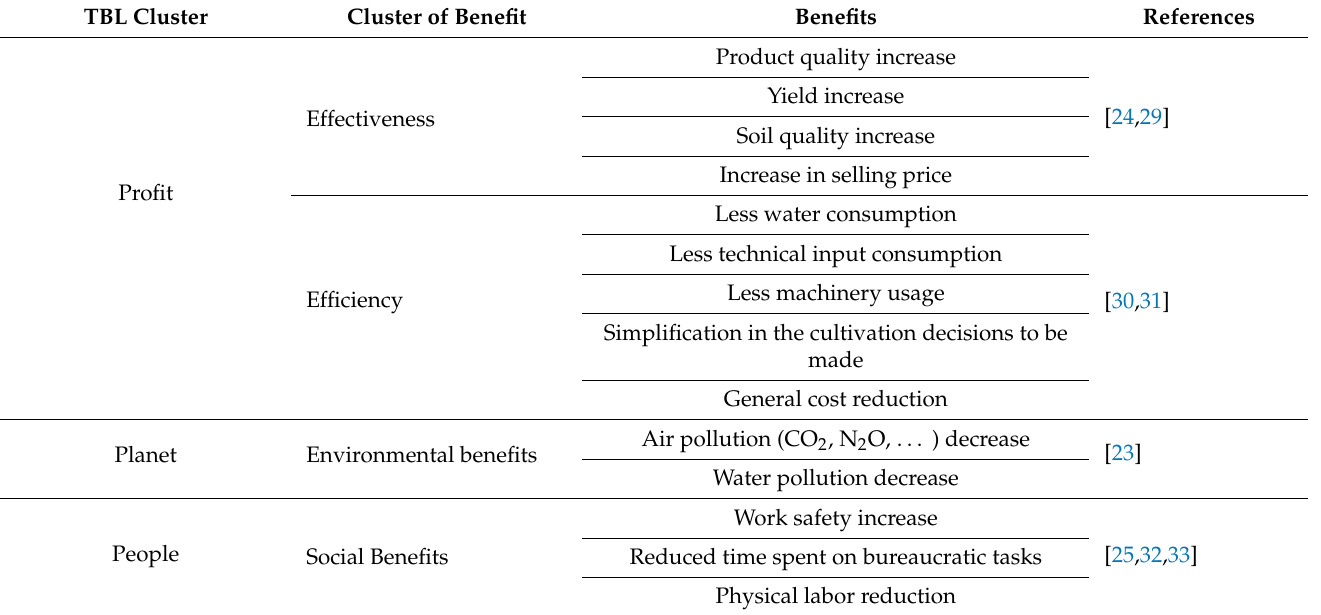
Table 2. List of